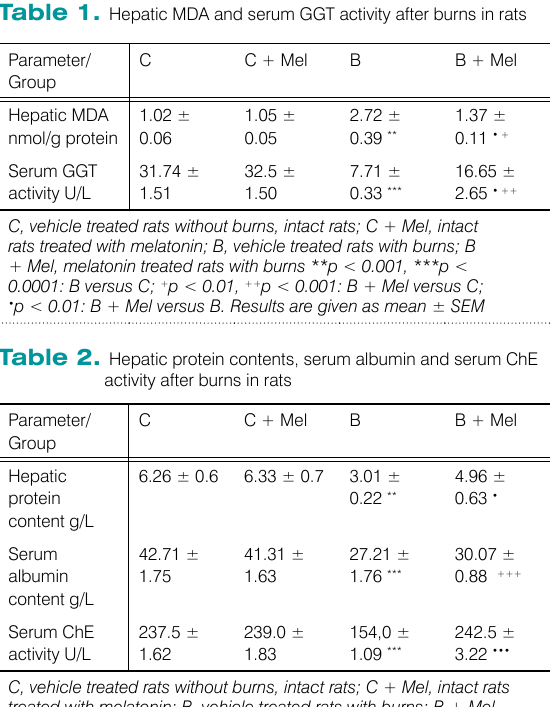
C, vehicle treated rats without burns, intact rats; C + Mel, intact rats treated with melatonin; B, vehicle treated rats with burns; B + Mel, melatonin treated rats with burns. ** p < 0.001, ***p < 0.0001: B versus C; +++ p < 0.0001 B + Mel versus C; • p < 0. 01, ••• p < 0.0001: B + Mel versus B. Results are given as mean ±